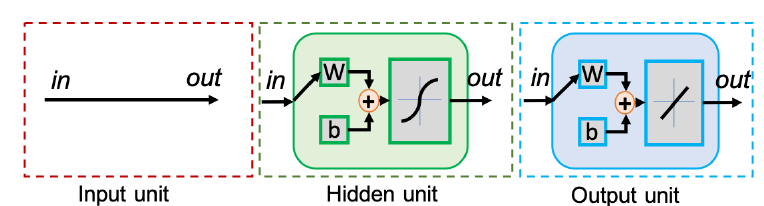
Figure 4. Nonlinear autoregressive neural network: neuron models of the input, hidden and output layers.